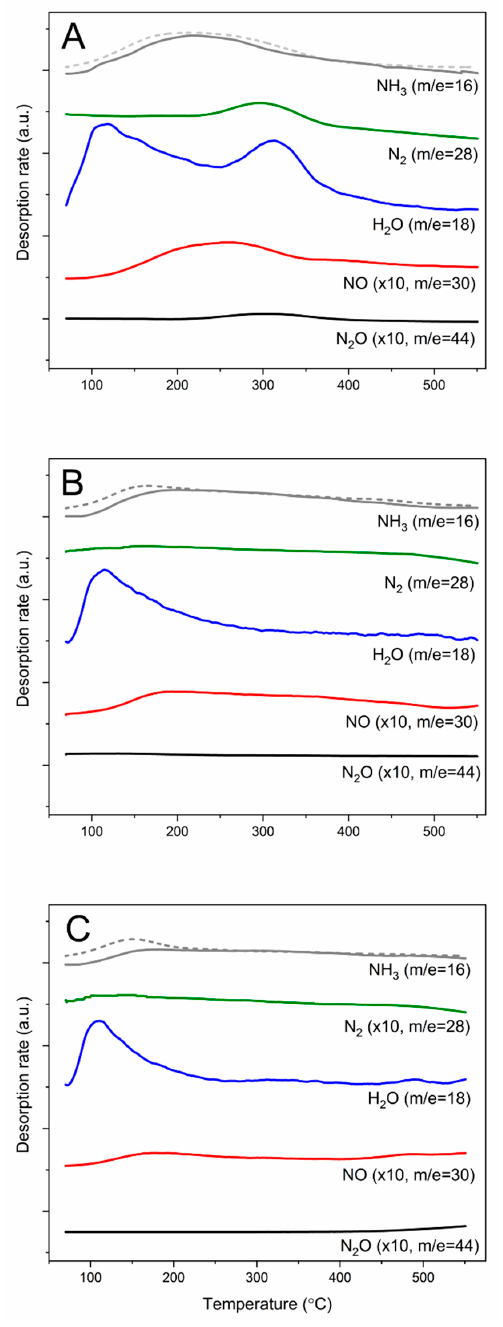
Figure 12. Results of NH 3 -SCO temperature-programmed surface reaction for 25Cu-MCM-41 ( A ), 20Fe-MCM-41 ( B ), and 100Fe-MCM-41 ( C ).